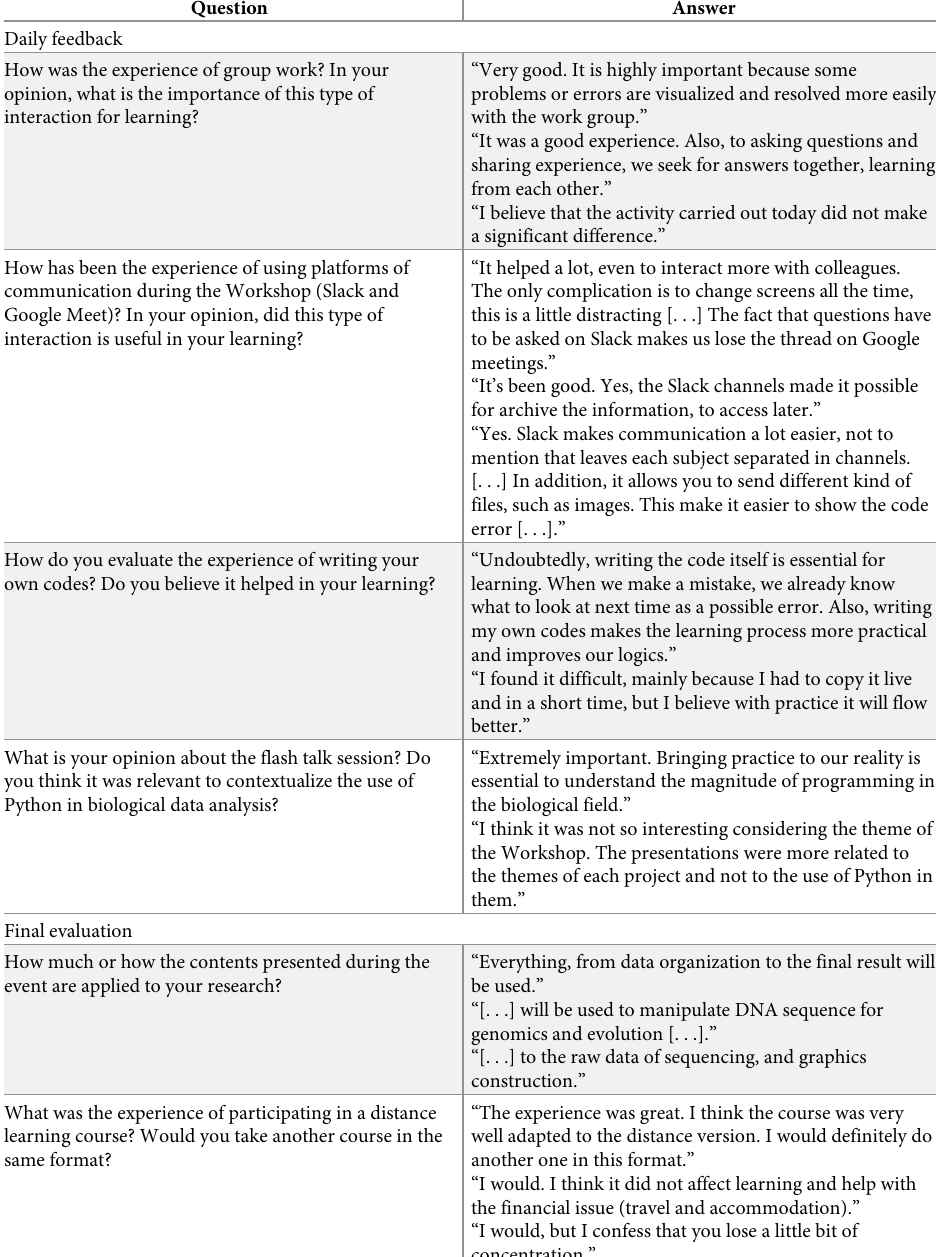
Table 1. Quotes from students with feedback obtained from daily and final surveys (quotes have been translated from